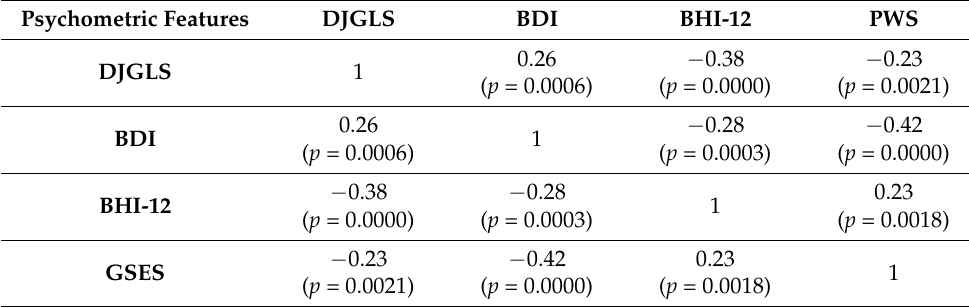
Table 3. Correlations between the psychometric scales used. Psychometric